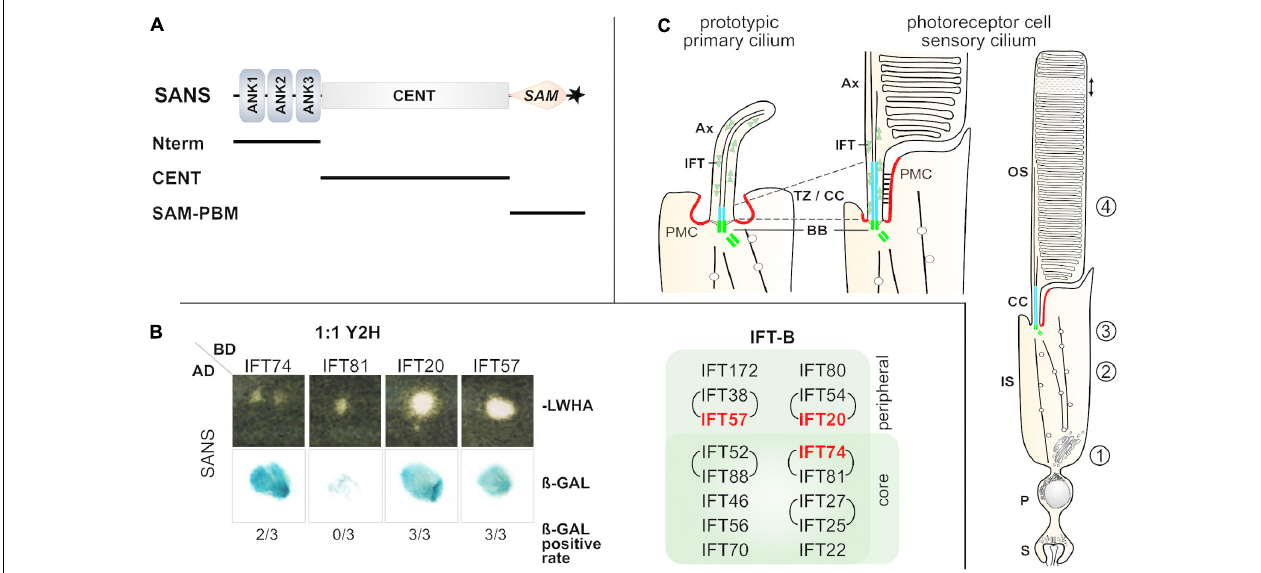
FIGURE 1 | SANS-IFT binary interactions were identified via 1:1 Yeast-two-hybrid. (A) Scheme of domain composition of human SANS protein. SANS has 461 aa and a molecular weight of 51 kDa and is composed of the following domains: 3 ANK, ankyrin repeats in the SANS_Nterm; CENT, central domain; SAM, sterile alpha motif; ∗ PBM, PDZ binding motif. SANS deletion constructs, which were used for GFP-Traps are indicated below by black lines. (B) 1:1 Y2H assay. Representative yeast colonies on –LWHA selection media and positive ß-galactosidase assay revealed binding of SANS full length to several IFT-B proteins. For all IFTs three Y2H assays were performed. The rate of ß-GAL positive tests is indicated below, e.g., 2 out of 3 for IFT74 (2/3). Positive hits are highlighted in the IFT-B composition overview in red. (C) Schemes of a prototypic cilium and a photoreceptor cilium. Both share homolog structures and common ciliary transport modules: the outer segment (OS) of photoreceptors resembles the ciliary shaft with axoneme (Ax) of the prototypic cilium, and the connecting cilium corresponds to the transition zone (TZ, blue). Intracellular transport for the delivery of ciliary proteins to the outer segment is organized in multiple modules: cargo sorting and vesicle budding at the Golgi apparatus (1), microtubule guided vectorial transport through the inner segment via cytoplasmic dynein (2), vesicle fusion with the periciliary membrane complex (PCM, red) and cargo reloading/assembly at the ciliary base (3) and finally, intra-ciliary transport along the CC/TZ and the Ax (4), mediated by intraflagellar transport (IFT) complexes (IFT-B/kinesin II or IFT-A/dynein-2) or by myosin VIIa, respectively. BB, basal body, green; P, perikaryon, S,